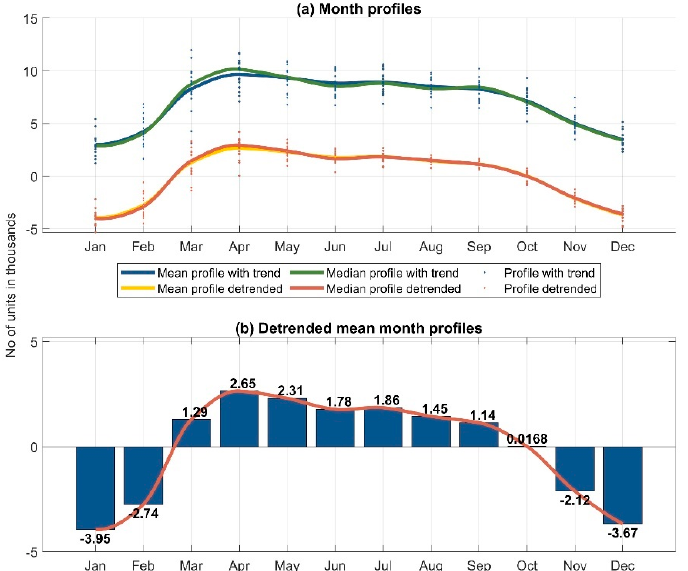
Figure 5. Averaged annual profile. Housing units whose construction has begun—individual (Source: own compilation based on data from CSO).